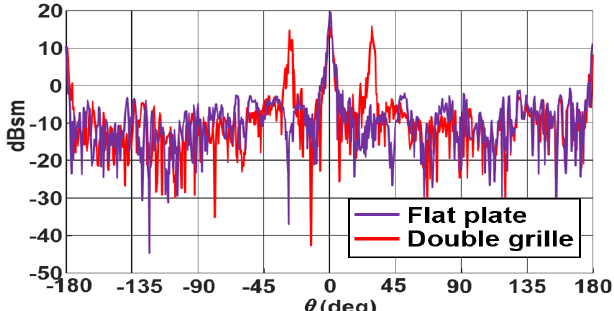
Figure 7. Metallic grille and flat plate monostatic RCS results in near-field conditions (at 5.50 m): Figure 7. measurements.